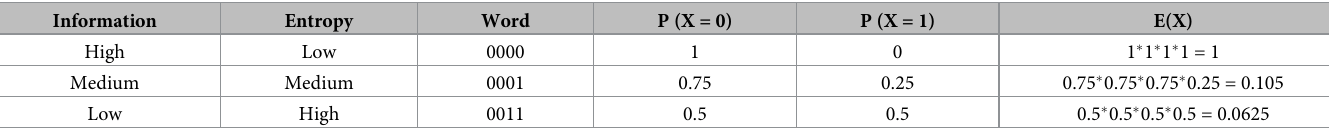
Table 3. Relation between the level of uncertainty and knowledge about possible string